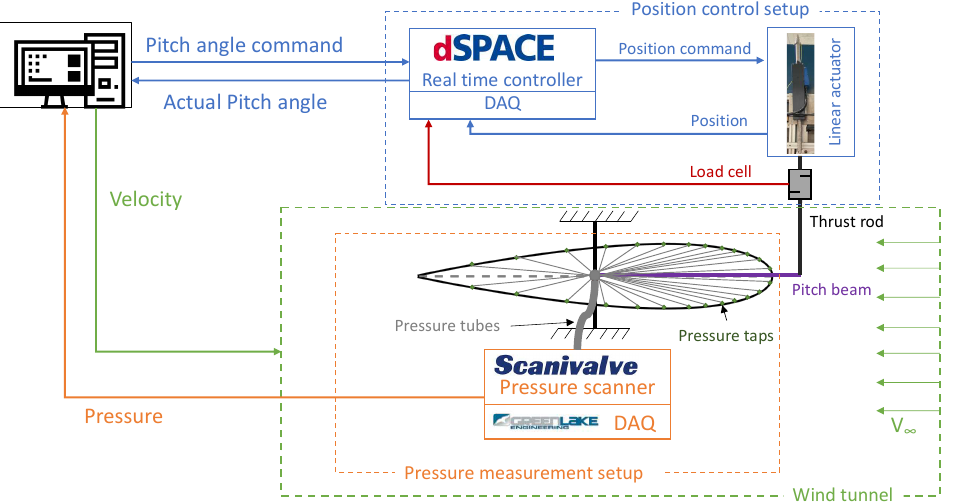
Figure 4. Schematic of the experimental setup with a detailed description of the position control and pressure measurement setup.